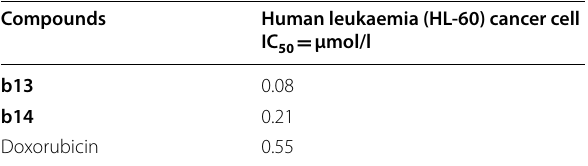
Table 18 Anticancer activity results of compounds b6 and b7 Compounds